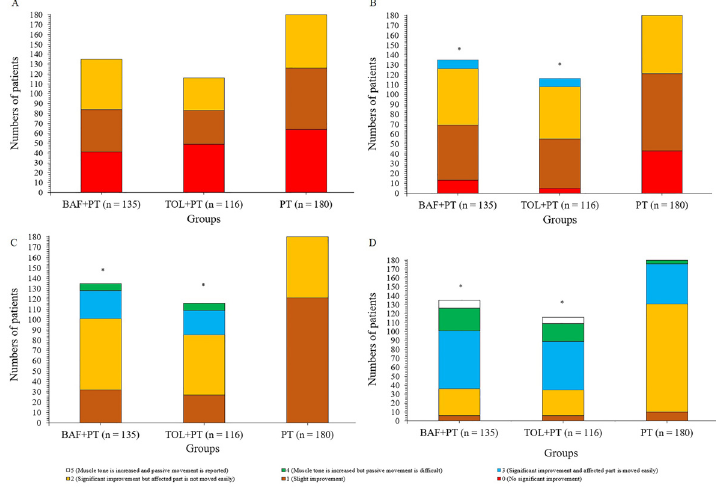
Figure 2. The modi fi ed Ashworth scales score of patients at different points of evaluation. A , Before the start of interventions. B , C , and D , at 2, 4, and 6 weeks after the start of interventions, respectively. *P o 0.05 compared to the PT group (ANOVA). BAF + PT: baclofen plus physical therapy; TOL + PT: tolperisone plus physical therapy; PT: physical therapy